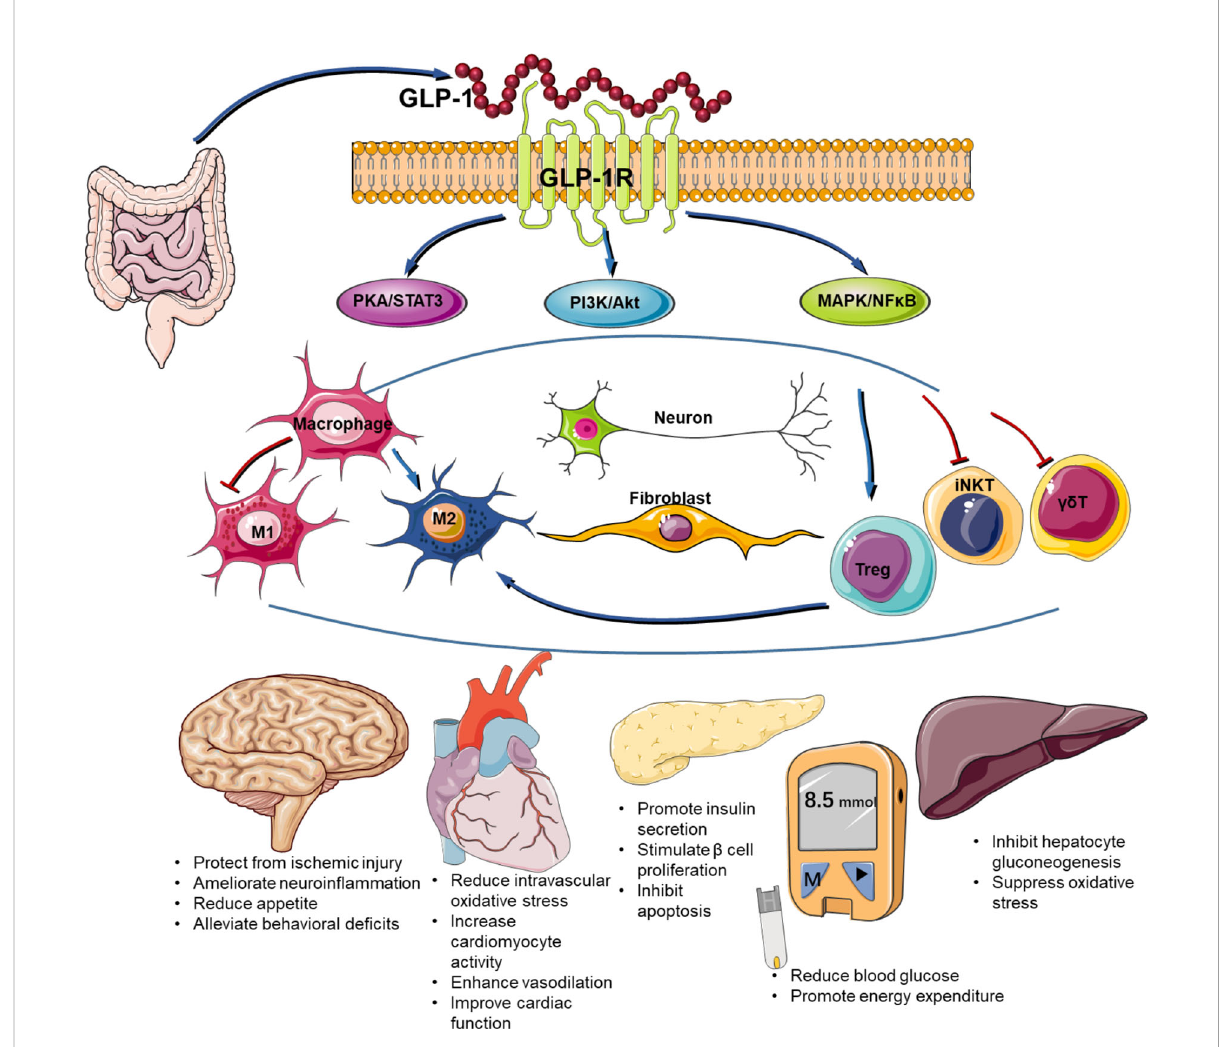
FIGURE 1 Immune regulatory function of GLP-1/GLP-1R